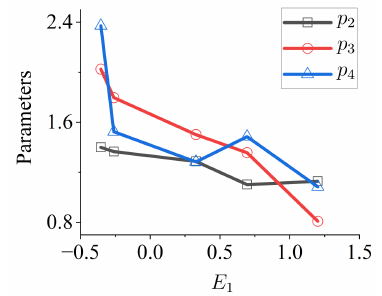
Figure 17. Identified values of p 2 , p 3 , and p 4 .